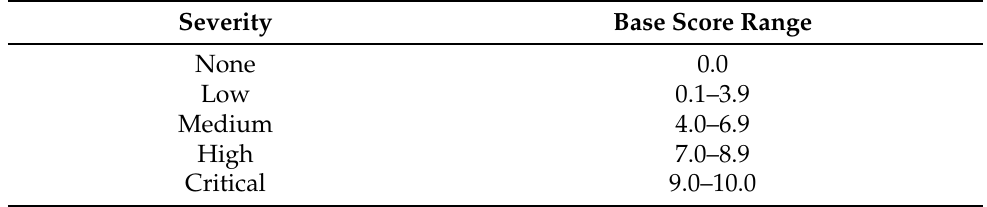
Table 1. CVSS V3.0 ratings.